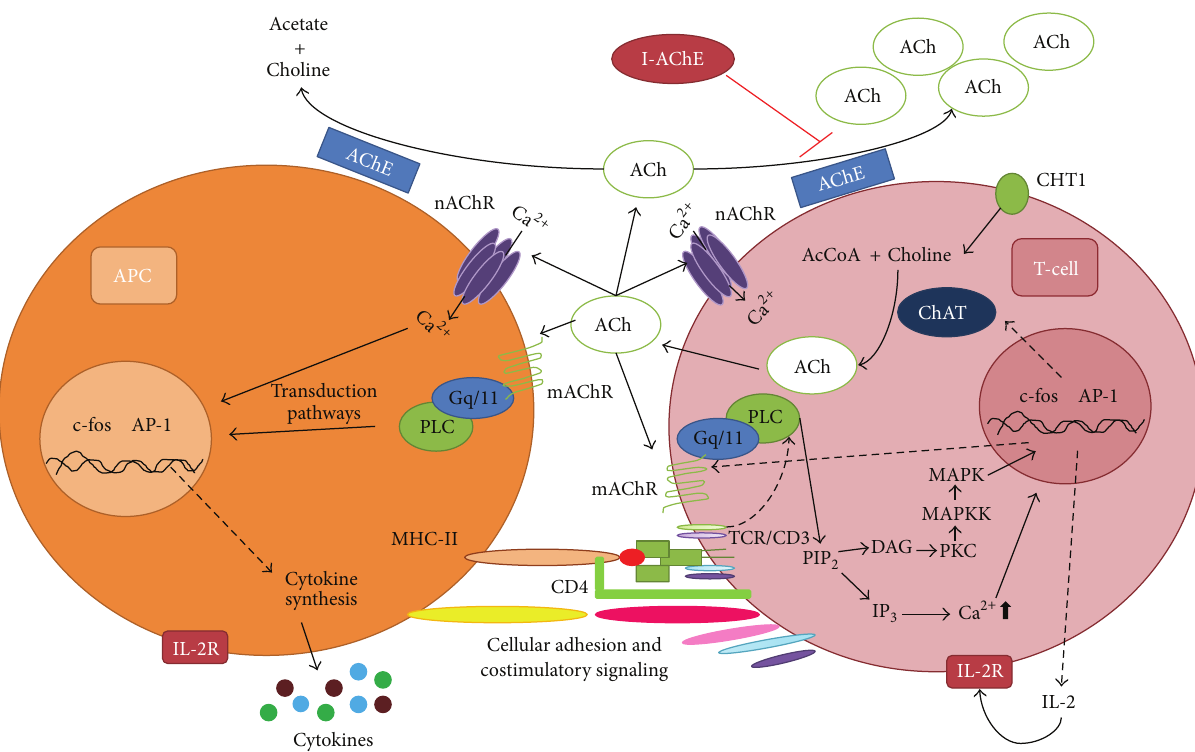
Figure 4: Cholinergic system in cells of the immune system and the effect of acetylcholinesterase inhibitors in mammals. AcCoA: acetyl coenzyme; Ach: acetylcholine; AChE: acetylcholinesterase; AP1: activator protein 1; APC: antigen presenting cell; ChAT: choline acetyltransferase; CHT1: high-affinity choline transporter; DAG: diacyl glycerol; I-AChE: acetylcholinesterase inhibitor; IL-2: interleukin 2; IP 3 : inositol-1,4,5-trisphosphate; mAChR: muscarinic ACh receptor; MAPK: mitogen activated protein kinase; MAPKK: MAP kinase kinase; MHC II: major histocompatibility complex class II; nAChR: nicotinic ACh receptor; PIP 2 : phosphatidylinositol 4,5-bisphosphate; PKC: protein kinase C; PLC: phospholipase C; TCR: T-cell receptor (adapted from [33,